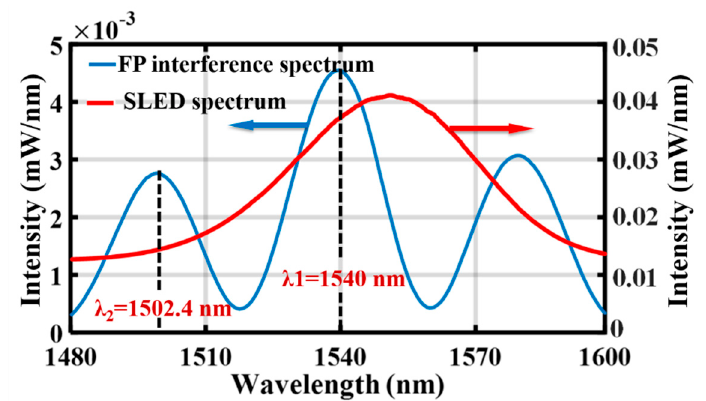
Figure 7. Interference spectrum of the FP cavity together with the superluminescent light emitting diode (SLED) spectrum.